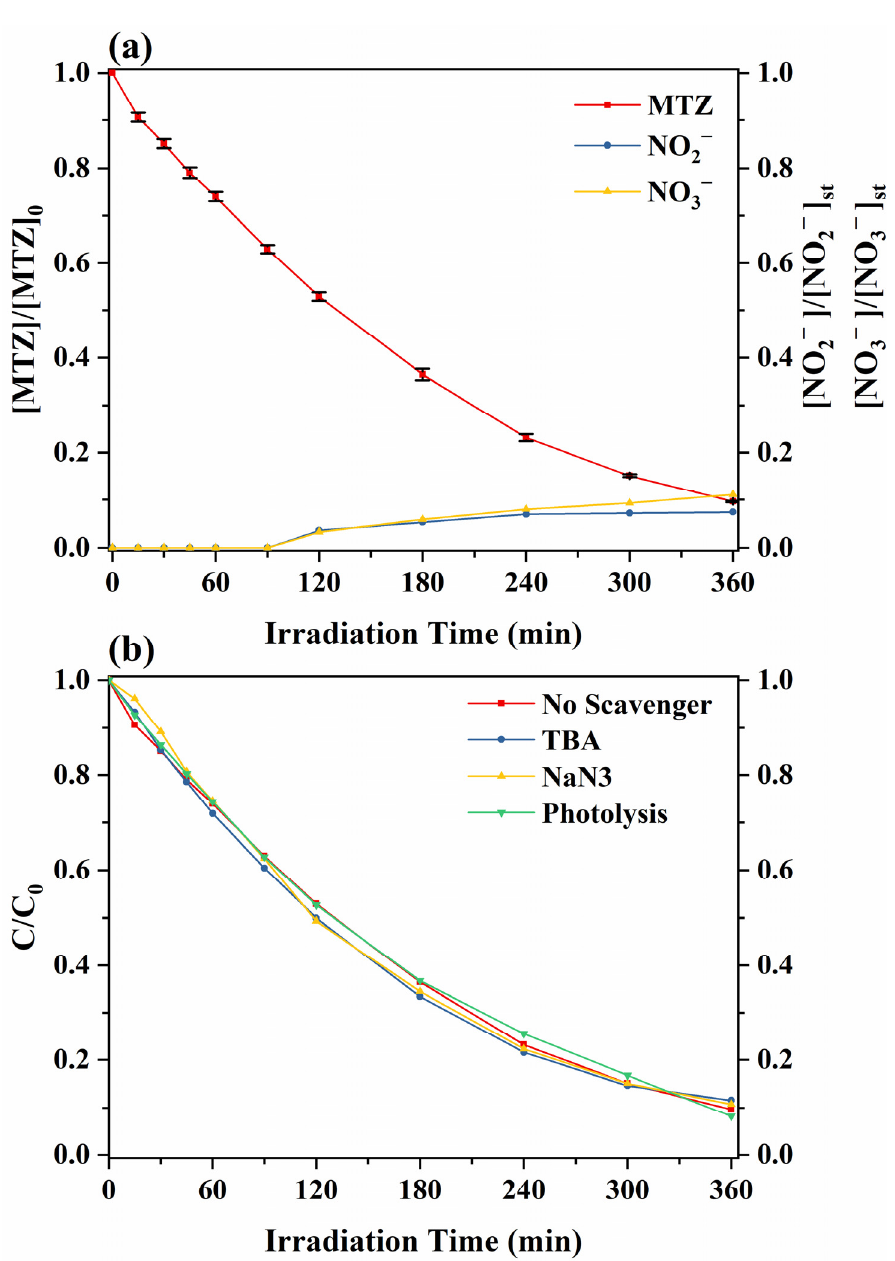
Figure 1. ( a ) Photocatalytic removal kinetics of MTZ (C 0 = 10 mg L − 1 ) with g-C 3 N 4 (100 mg L − 1 ) and evolution kinetics of the produced NO 2 − & NO 3 − under lab scale conditions. ( b ) Photolytic and photocatalytic (g-C 3 N 4 , 100 mg L − 1 ) removal kinetics of MTZ (C 0 = 10 mg L − 1 ) in the presence of scavengers (C scav :C 0 = 1000:1).